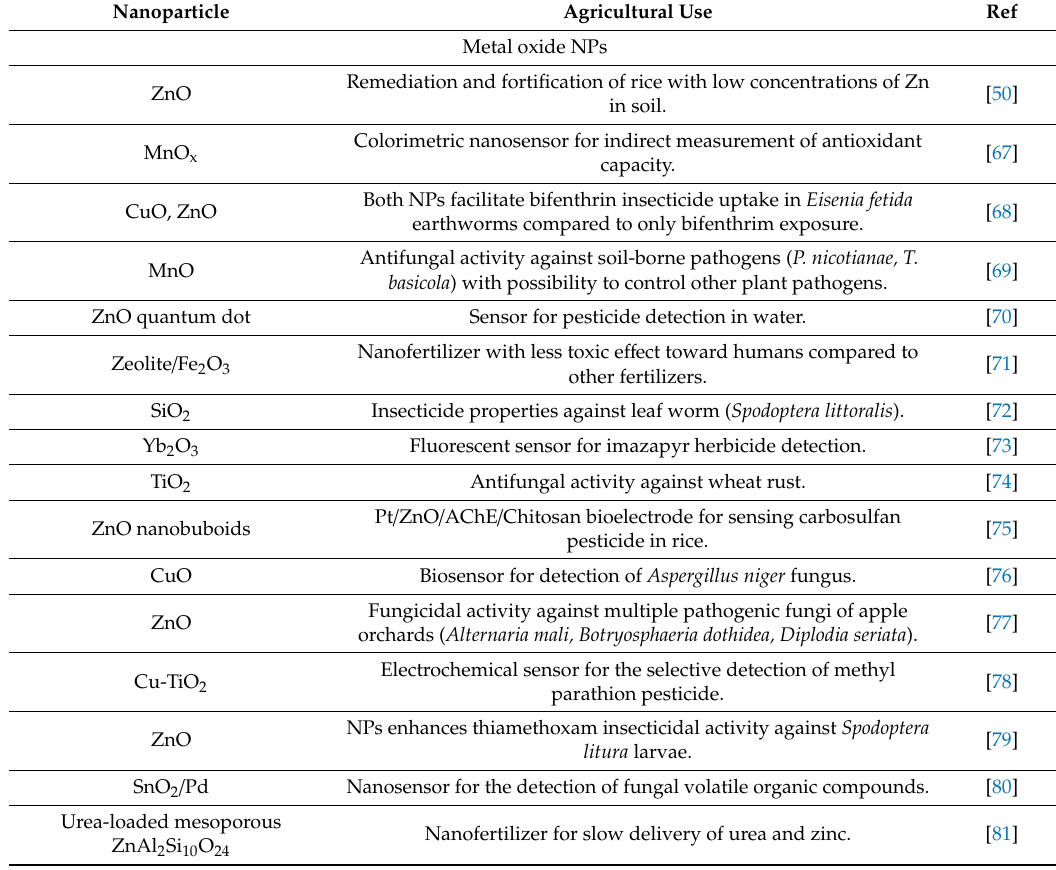
Table 1. Agricultural applications of nanoparticles